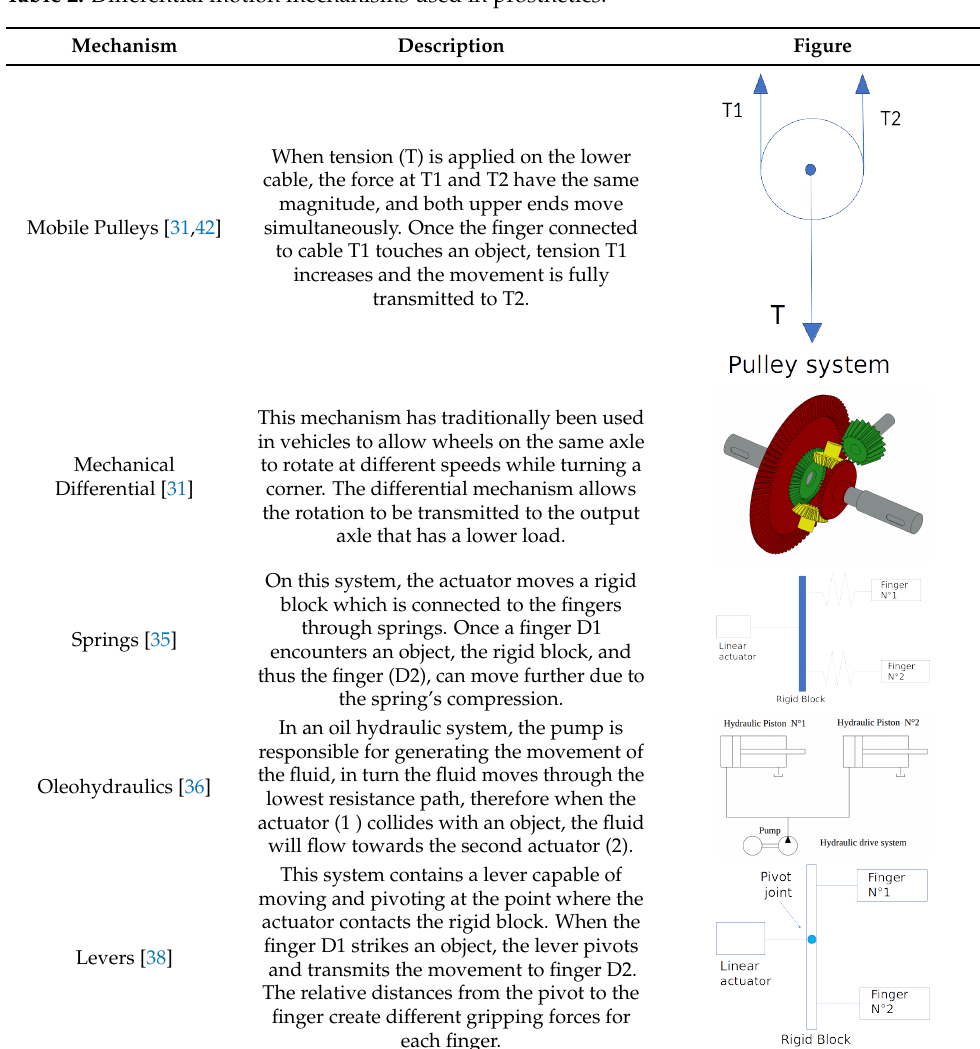
Table 2. Differential motion mechanisms used in